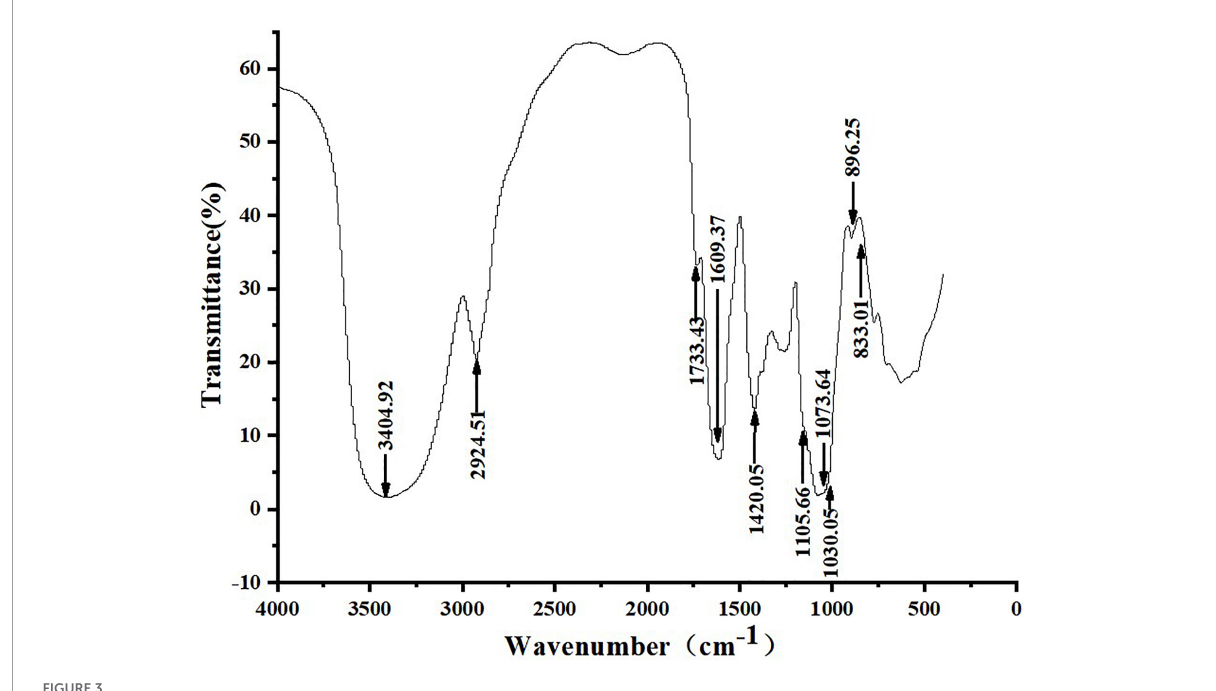
FIGURE3 Fourier transform infrared spectrometer (FT-IR) spectrum of ZSPP-1.